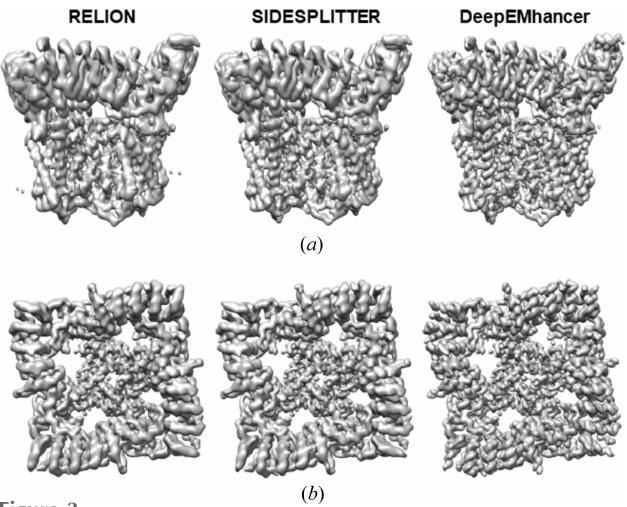
Figure 3 Refinements of 87603 particle images of TRPV5 in lipid nanodiscs (EMPIAR-10254). Comparison of refinement results using standard RELION , SIDESPLITTER and deepEMhancer . No local filtering or sharpening operations were used and the threshold was set to keep the enclosed volume constant. ( a ) Side view and ( b ) top view of the reconstructions.